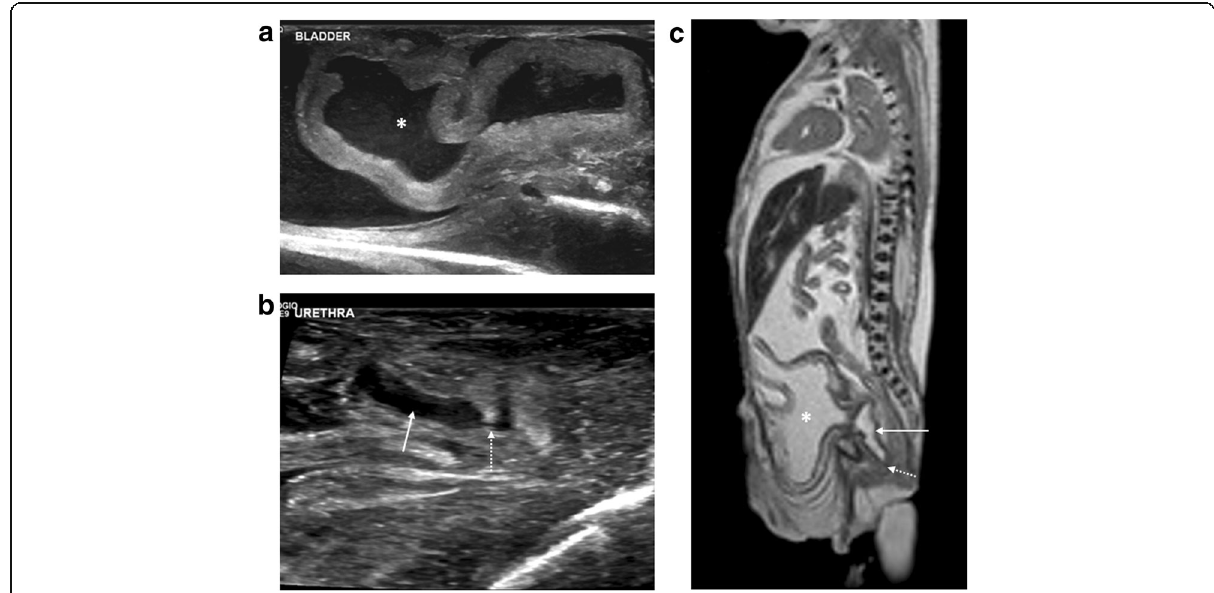
Fig. 17 Bladder outlet obstruction due to posterior urethral valves in a foetus at 21weeks gestation. The post-mortem imaging was obtained three days after termination of pregnancy. Sagittal post-mortem ultrasound images of the bladder ( a ) and posterior urethra ( b ) demonstrate a partially distended urinary bladder (asterisk) with thickened bladder wall, a dilated posterior urethra (solid arrow) and an abrupt urethral narrowing (dotted arrow) at site of obstruction. The corresponding sagittal post-mortem T2 weighted MRI study ( c ) also demonstrates the large urinary bladder (asterisk) with dilated posterior urethra (solid arrow), although the site of obstruction (dotted arrow) is less well depicted than on the ultrasound